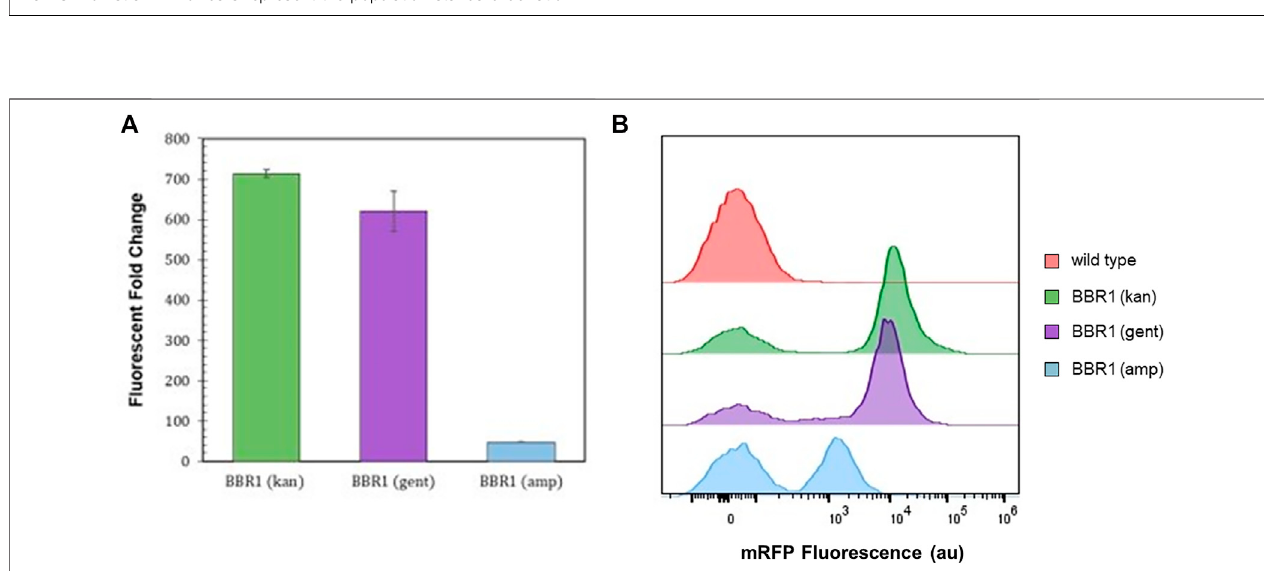
FIGURE3| Expressiontestsand fl owcytometryresults (A) Average fl uorescentfoldchangeof R.palustris BBR1-kan-mRFP,BBR1-gent-mRFP,andBBR1-amp- mRFP strains grown intriplicate. The antibiotic concentrationsaddedtothemediaofthemutant strains but notwildtype R.palustris were300 μ g/mlkanamycinsulfate,